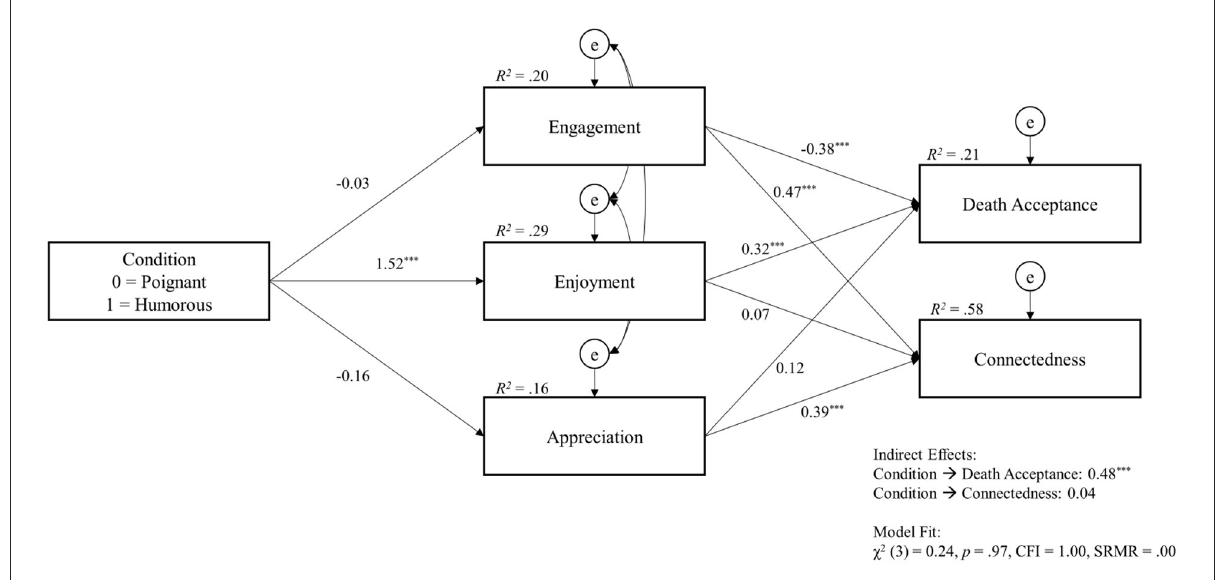
FIGURE3 Path model results. *** p <